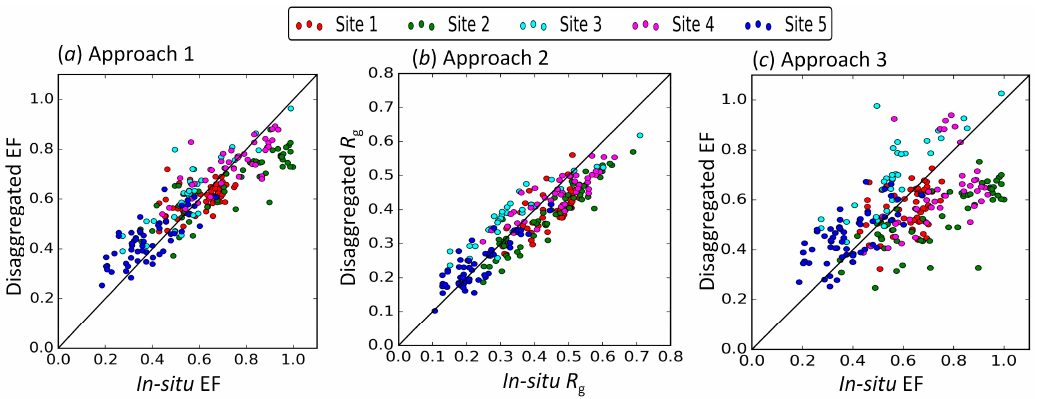
Figure 5. Comparison between ground observed and disaggregated ( a ) EF using the DEFrac model, ( b ) R g using the DiSoRa model, and ( c ) EF using the DisTrad thermal sharpening model over the five sites. Table 2. Results of comparison between ground observations, disaggregated EF, and disaggregated R g . Site